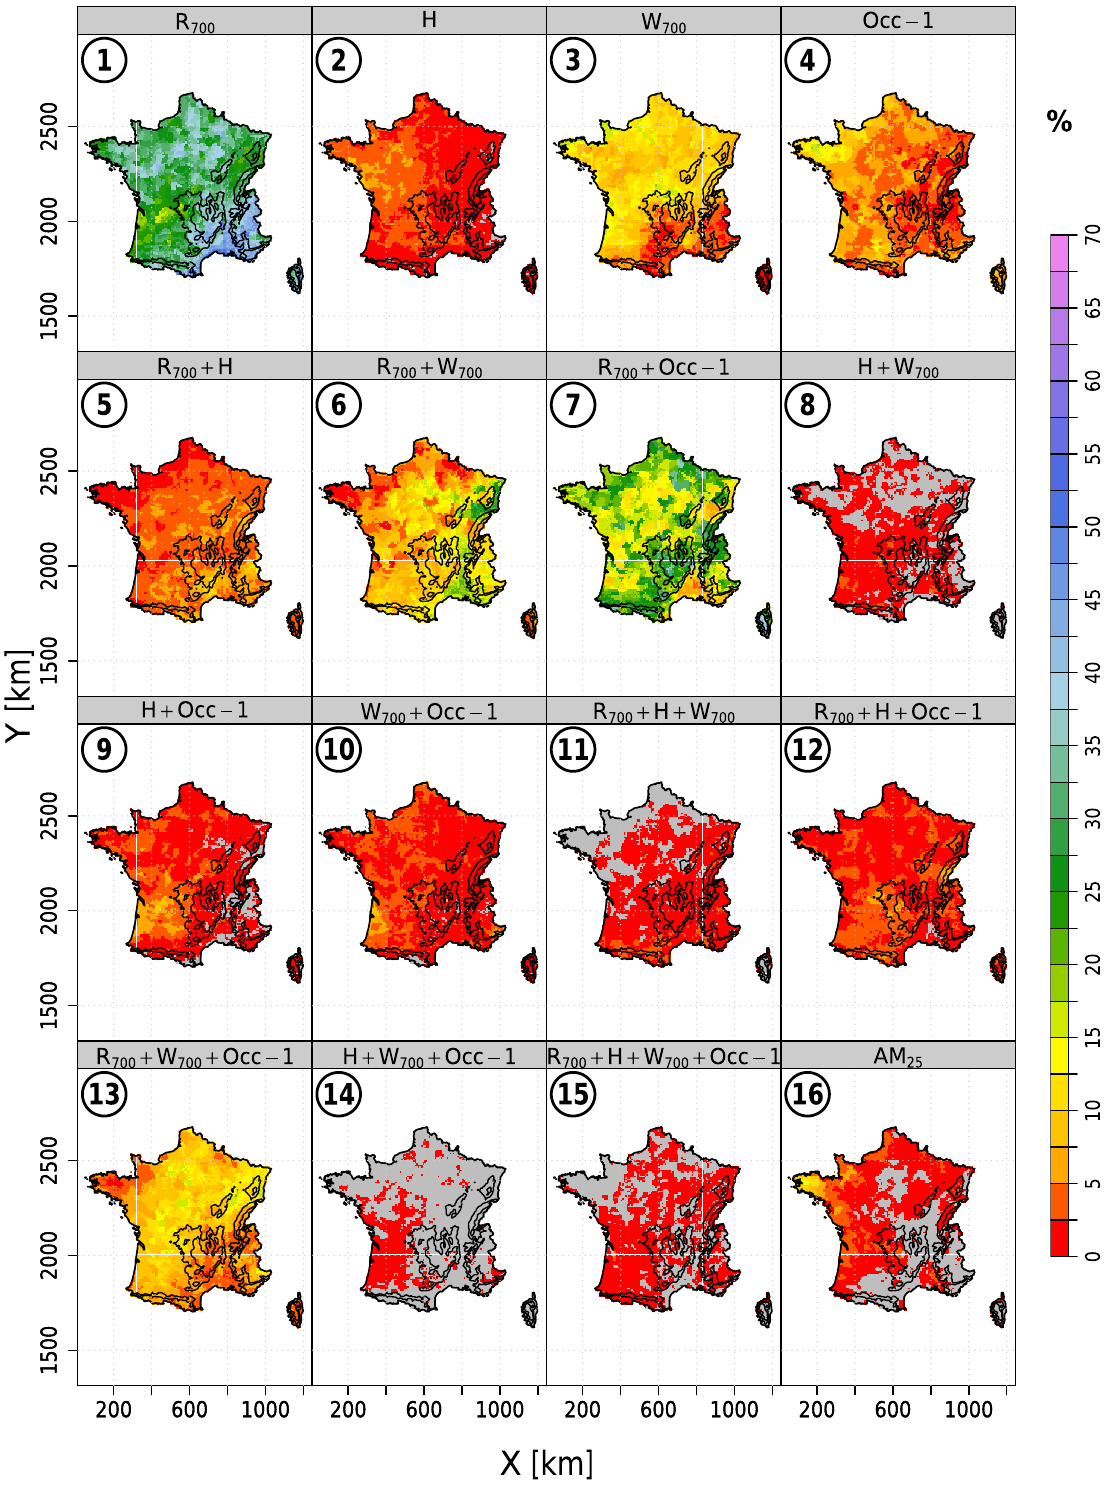
Figure 8. Prediction of occurrence probability: selection frequencies (%) of the 15 regression structures and of the backup model AM 25 . Predictors involved are indicated in the graph headers, and the index of the regressive structure in the top left corners. Gray grids: same as in Fig. 5. The selection frequency of AM 25 corresponds to the sum of those obtained for cases 1 and 3 in Fig.